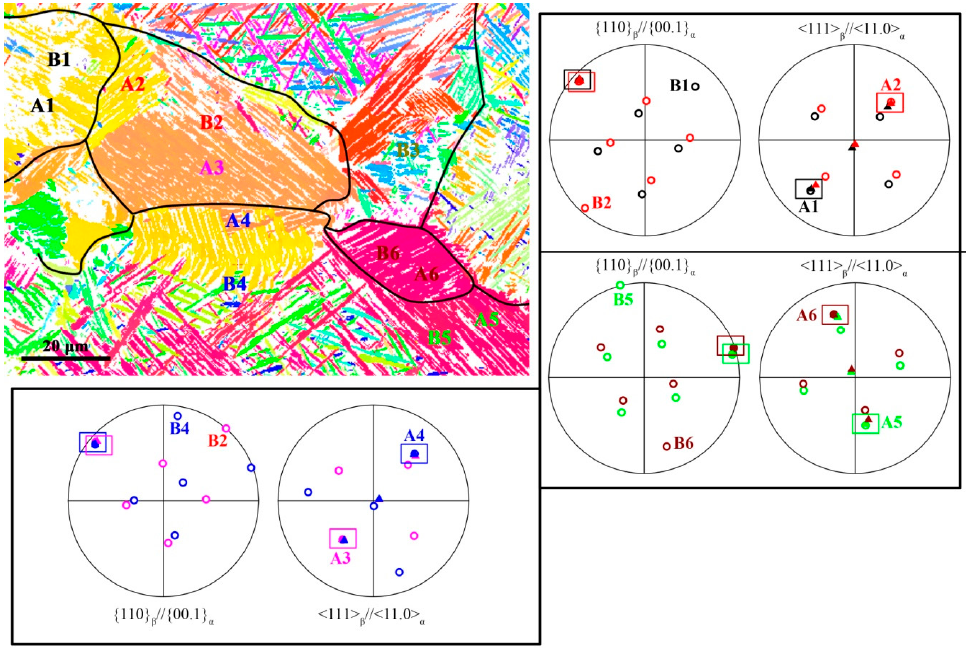
Figure 7. Local inverse pole figure map shows a group of Widmanstatten colonies in the sample deformed at 0.2 s − 1 . The compression direction is vertical. The prior grain boundaries are outlined on the map. The {00.1} and <11.0>pole figures are superimposing one the corresponding {110} and <111> pole figures, respectively. The coincident poles which manifest the strict Burger orientation relationship (BOR) are indicated by colored boxes.